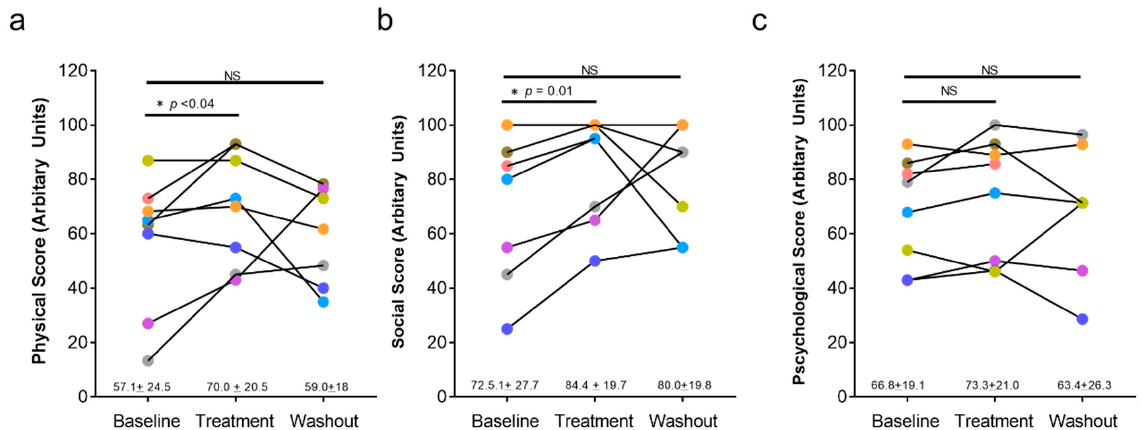
Figure 2. Effects of QBX258 treatment on quality of life measured using the ULL-27. ( a ) Quantification of physical score at baseline, following treatment, and following washout period in each patient over time. Average score for the cohort ± SD is shown below the graph. ( b ) Quantification of social score at each time point for all patients. ( c ) Quantification of psychological score at each time point for all patients.